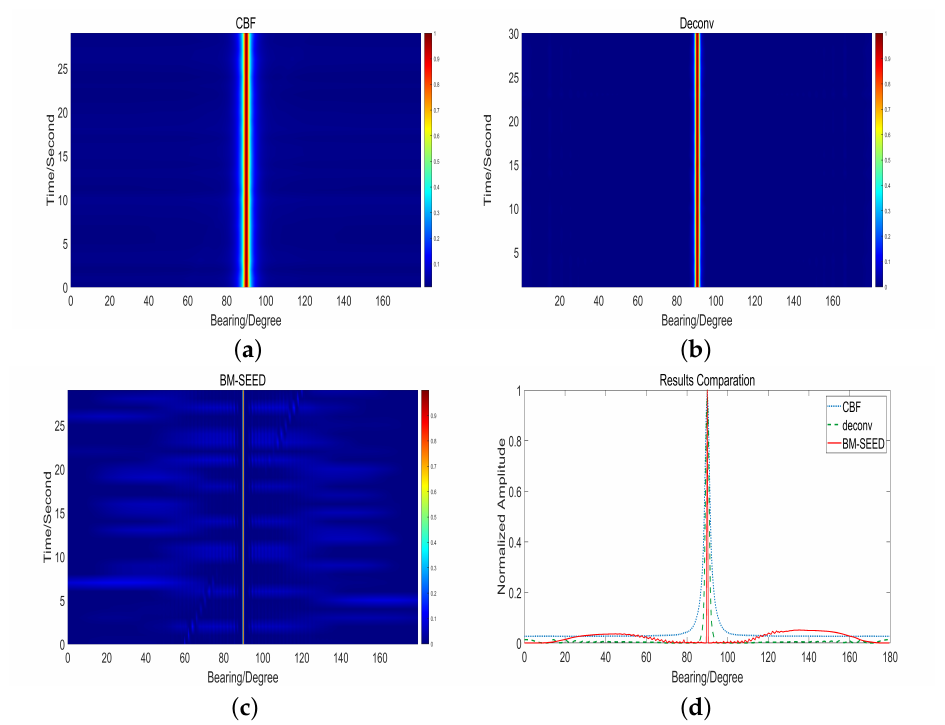
Figure 5. Experiment Results under − 25 dB SIR. ( a ) CBF result under − 25 dB SIR; ( b ) Deconv result under − 25 dB SIR; ( c ) BM-SEED result under − 25 dB SIR; ( d ) Results-Comparison under − 25 dB